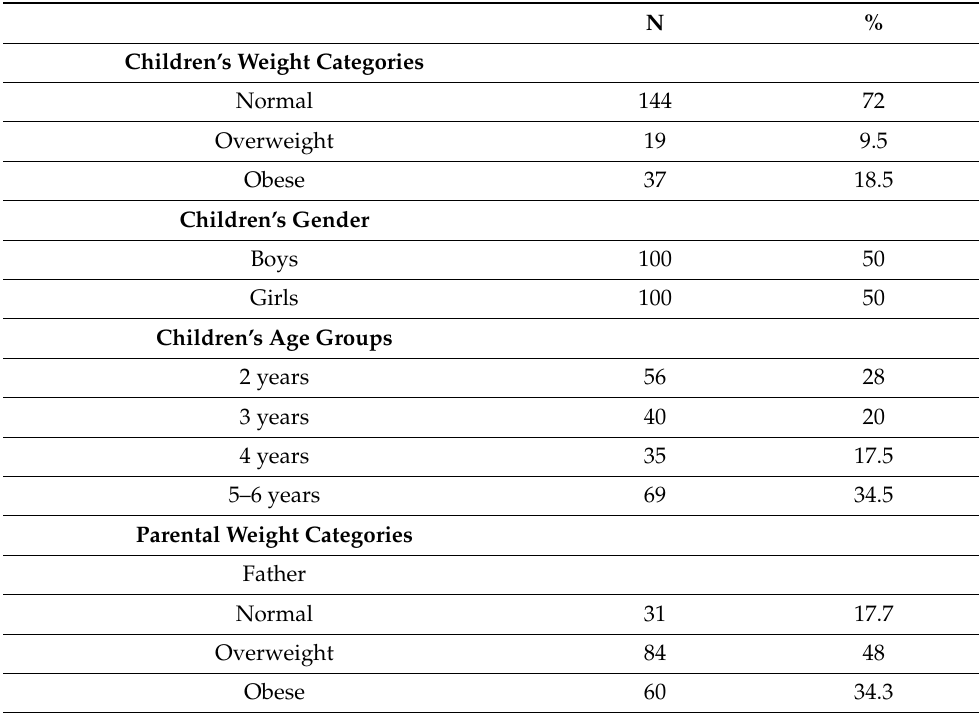
Table 1. Demographic and anthropometric characteristics of survey respondents (N =